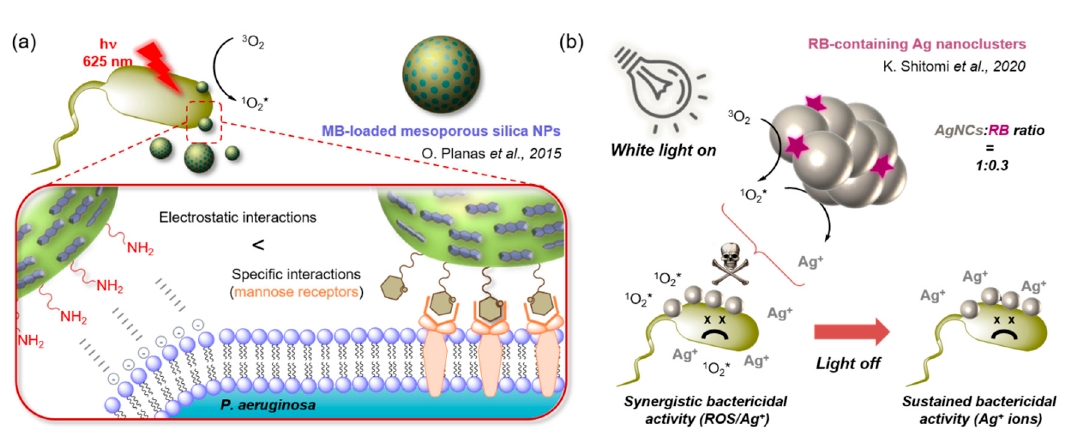
Figure 12. ( a ) Comparison of the bacterial specificity reported for amino- and mannose-functionalised MB-loaded mesoporous silica NPs for aPDT treatment of P. aeruginosa [153]; ( b ) Bactericidal modes of action of (RB)-containing silver nano-clusters during and after light irradiation